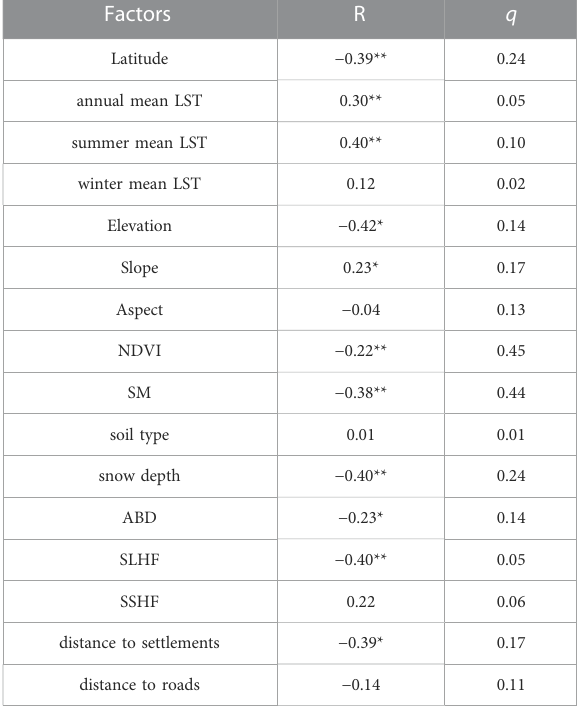
TABLE 4 Correlation coef fi cients and q values between in fl uence factors and ALT.